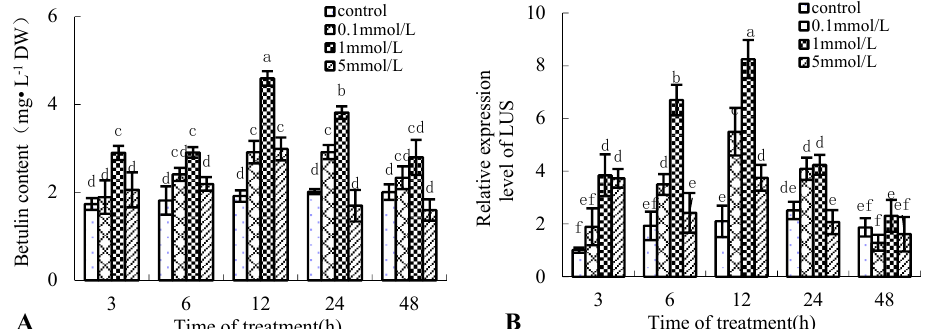
Figure 1. E ff ect of putrescine (Put) on betulin production and gene expression of lupeol synthase ( LUS ) in suspension cells of birch. Eight-day-old suspension cells were treated with 0.1, 1, and 5 mmol · L − 1 Put and harvested at the indicated time points after treatment. Suspension cells treated with the same volume of distilled water were used as controls. Di ff erent letters show significant di ff erences among means ( p < 0.05, Tukey’s test); the following figures are the same. ( A ), betulin content in suspension cells of birch; ( B ), gene expression of LUS in suspension cells of birch.